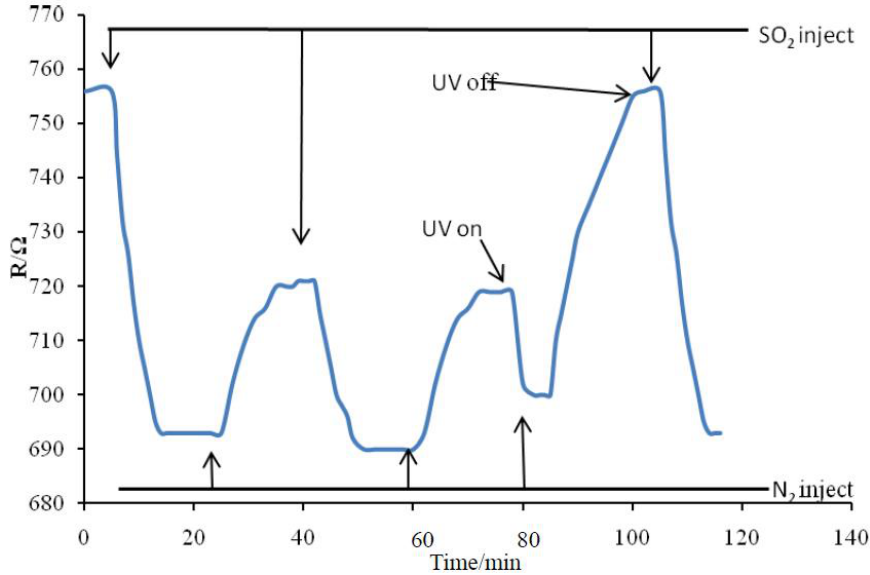
NTs sensor to SO 2